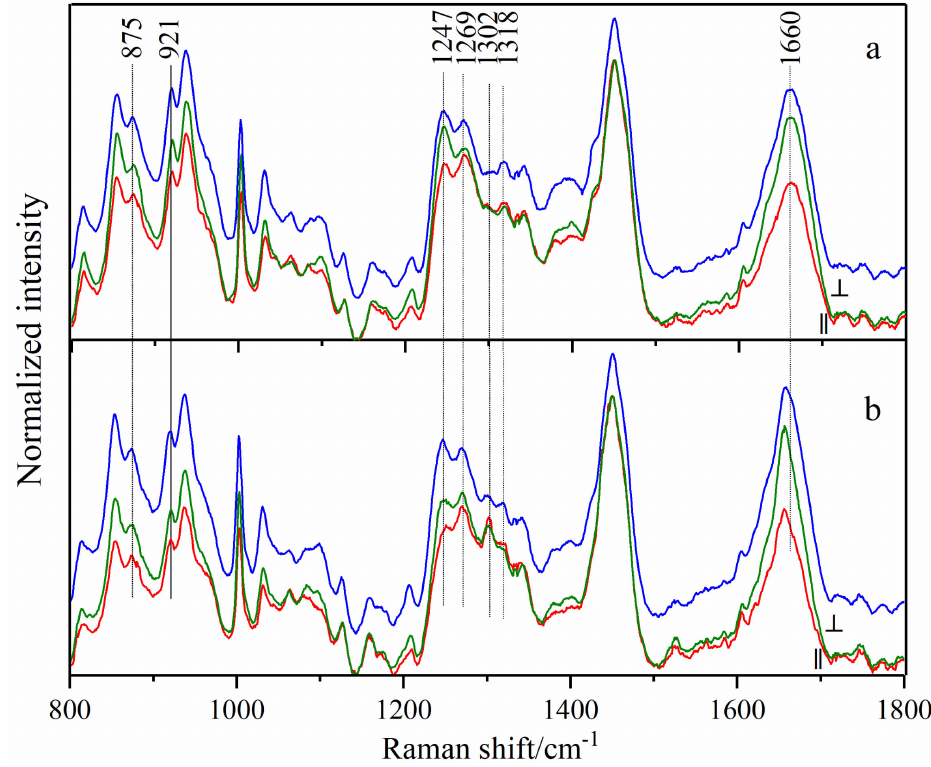
Figure 2. Polarized (red lines for parallel and green lines for perpendicular) and conventional (blue lines) Raman spectra of protein collected from normal ( a ) and cancerous ( b ) tissues. All shown are average spectra, which were normalized to the band of 1450 cm − 1 to reduce the influence of tissue heterogeneity,